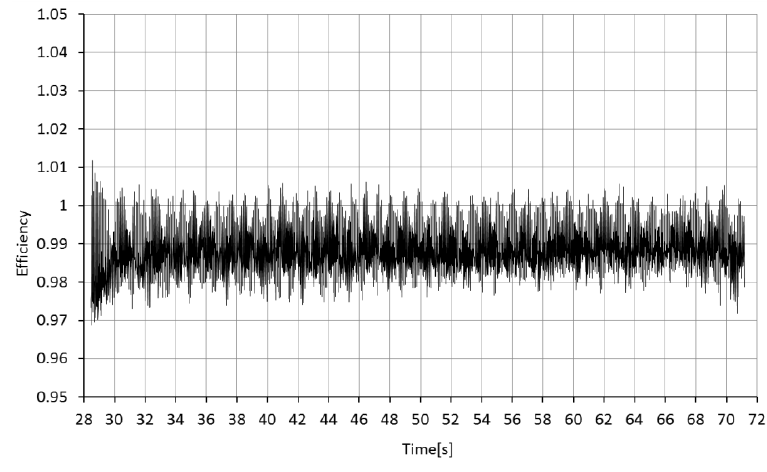
Figure 15. Efficiency measurement of the whole testbench chain.